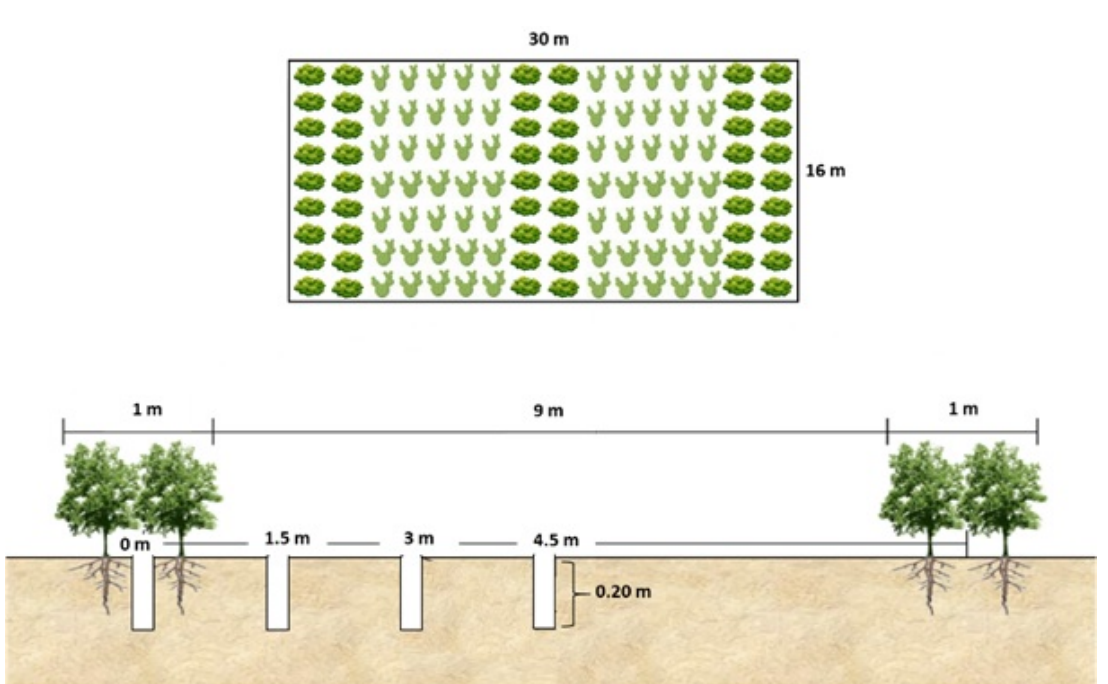
Figure 2. Layout of the soil sampling sites in the agroforestry systems using tree legumes and cactus; Caruaru-PE, Brazil.